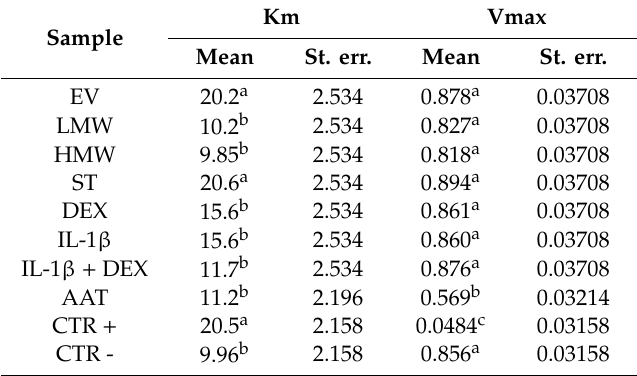
Table 3. Vmax and Km values for each sample analyzed. Multifactor ANOVA, mean values ± standard error, n = 9. Di ff erent letters (a, b, c) indicate significant di ff erences between the means ( p < 0.05), whereas the same letter indicates no significant di ff erence ( p > 0.05). Km Vmax Sample Mean St.